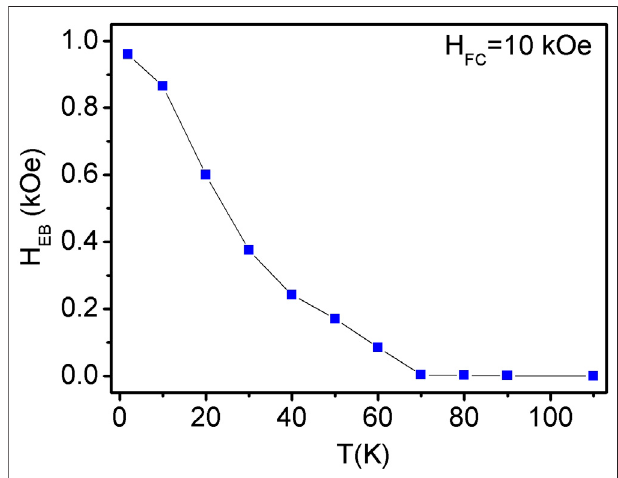
FIGURE 8 | Temperature dependence of the EB fi eld (H EB ) estimated from the M-H loops recorded at different temperatures after fi eld cooling at 10 kOe fi eld.